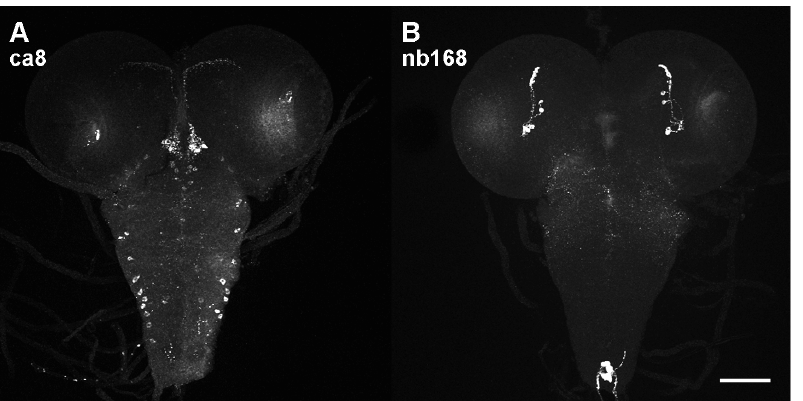
Figure 2. Z-projections of confocal stacks of larval nervous systems stained with two of the monoclonal antibodies shown in Figure 1. Larval staining of nb169 is shown in Figure 4K-M, the other seven antibodies did not produce reliable staining in the larval nervous system.